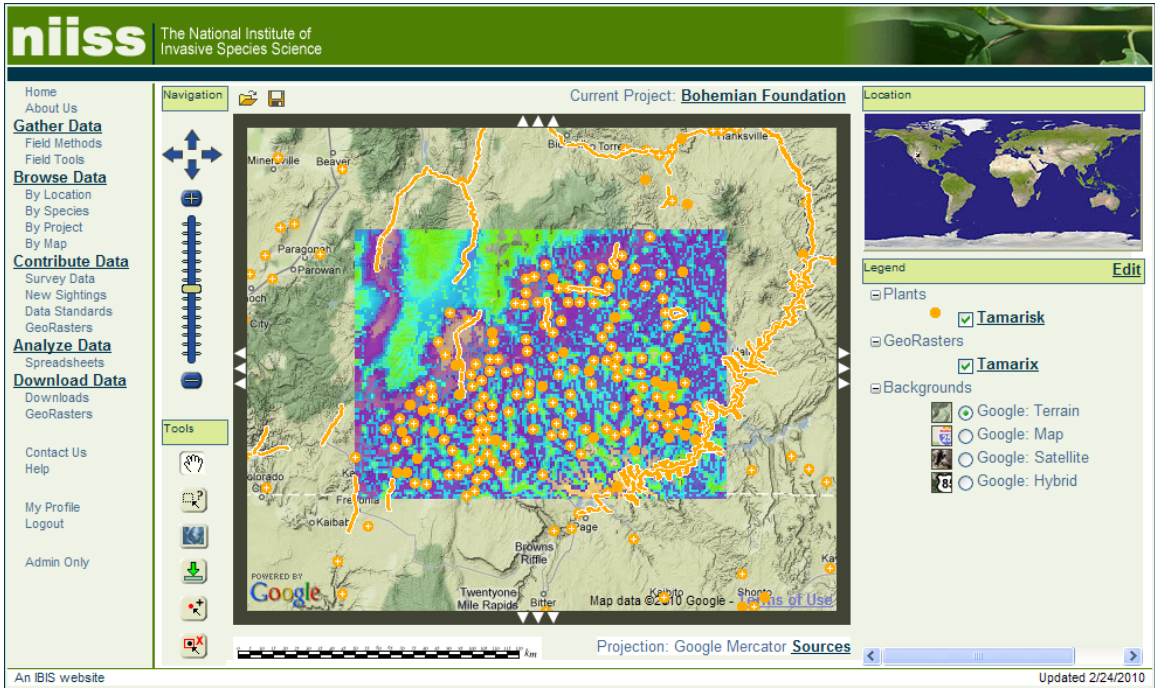
Figure 3. A screen capture of the mapping portion of the NIISS website with a model of the potential distribution of members of the genus Tamarix within the Grand Staircase-Escalante National Monument,